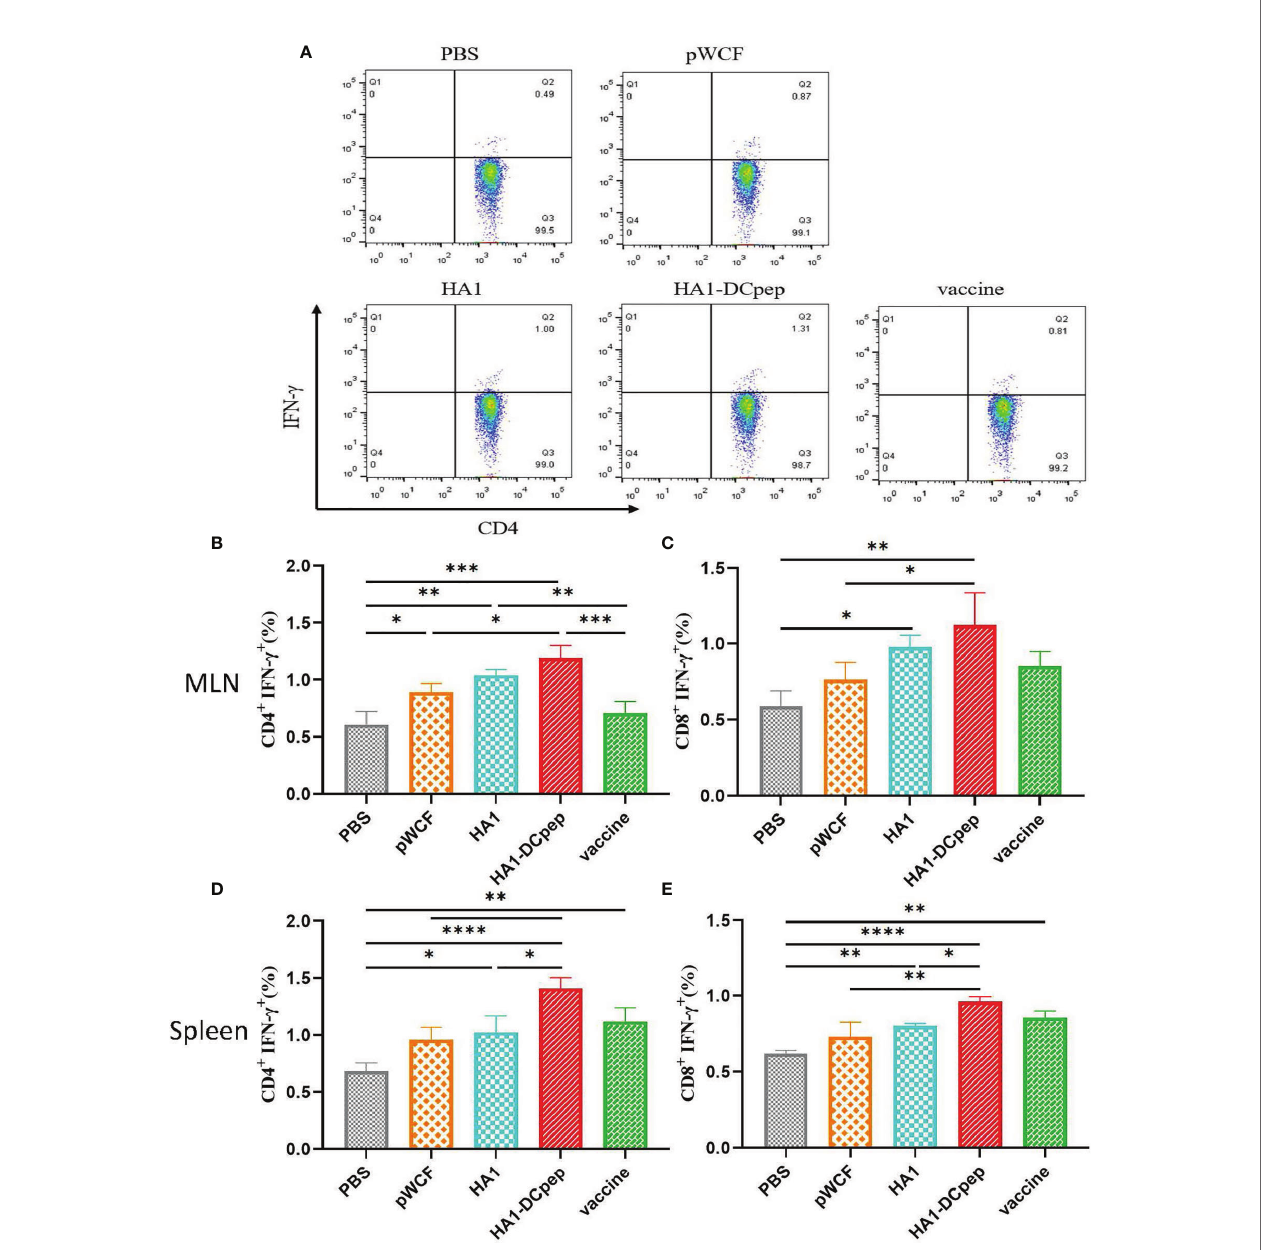
FIGURE 3 | Effect of recombinant L. plantarum on T cell responses. After booster immunization, mice MLNs and spleen were collected, and cell suspensions was prepared using a total of 1.5 ×10 6 cells for plates containing PMA and speci fi c antigenic peptides, and the plates were incubates for a total of 8 h. Scatter plots of CD4 + IFN- g + T cells in MLNs in different groups are displayed (A) . The numbers of CD4 + IFN- g + T cells (B) and CD8 + IFN- g + T cells (C) in the MLNs were detected by fl ow cytometry after antibody staining, and the numbers of CD4 + IFN- g + T cells (D) and CD8 + IFN- g + T cells (E) in the spleen were determined. Statistical signicance was assessed by one-way ANOVA (n = 3 mice per group). *P < 0.05; **P < 0.01; ***P < 0.001; ****P <